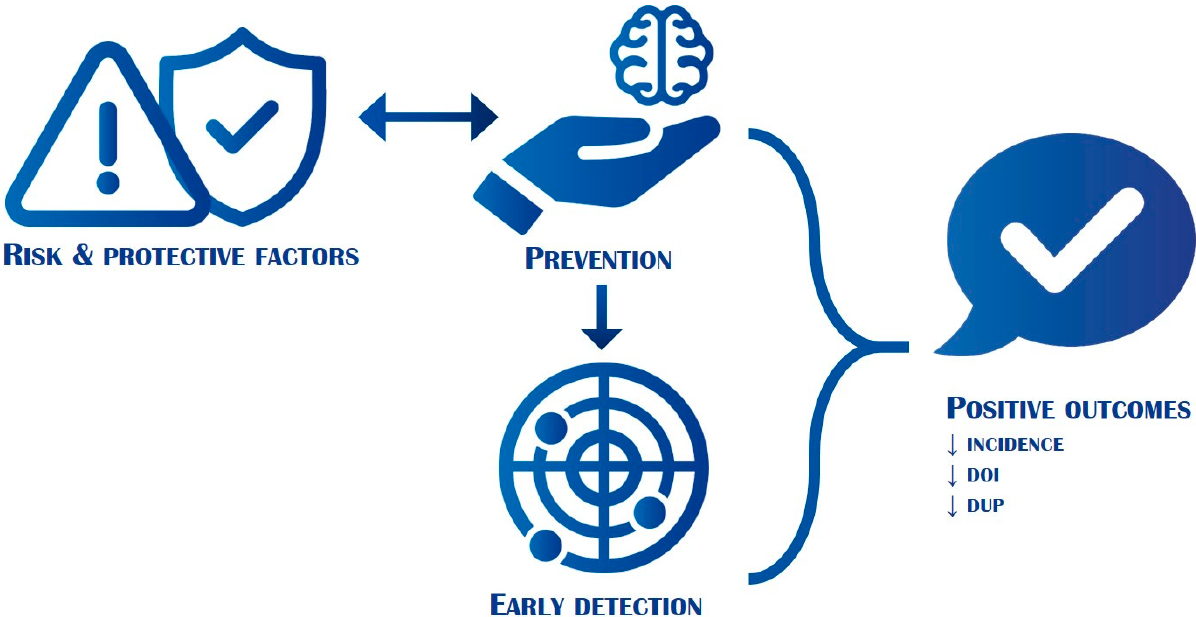
Figure 2. Interplay between risk and protective factors, prevention, early detection of the onset, and outcomes. DOI: duration of illness; DUP: duration of untreated psychosis. The figure shows how acting on risk and protective factors through prevention (horizontal arrow) and through an early detection of the onset (vertical arrow), is it possible to reduce the incidence, the DOI and the DUP of primary psychosis. This allows ameliorating the prognosis and lowering the global burden of disability of the disease (not shown).